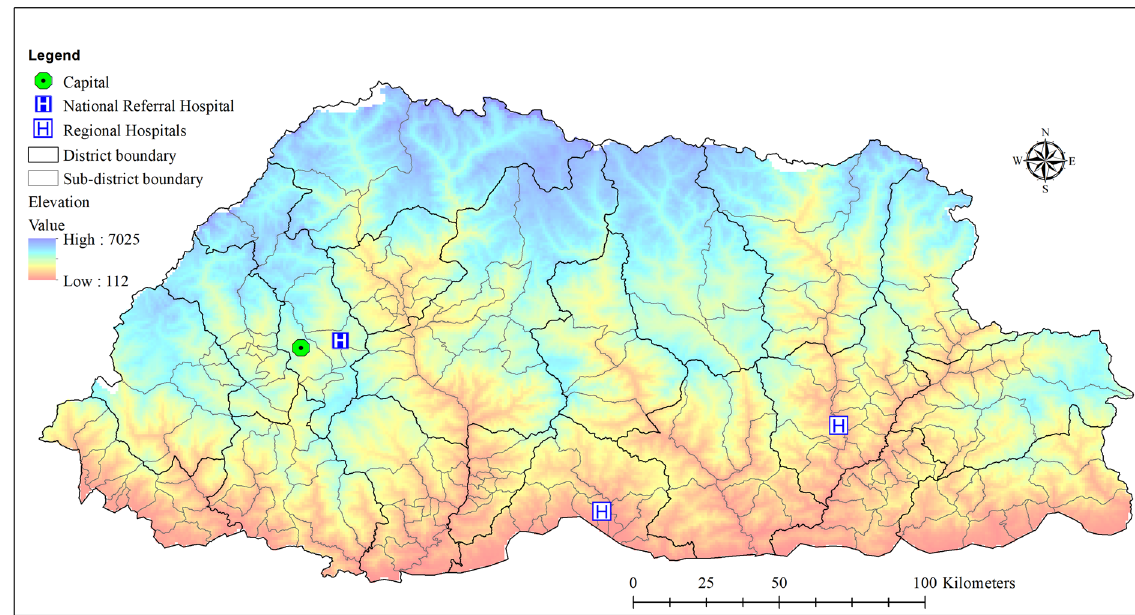
Figure 5. Bhutan map showing district and sub-district boundaries, capital, Paro international airport, elevation, regional and national referral